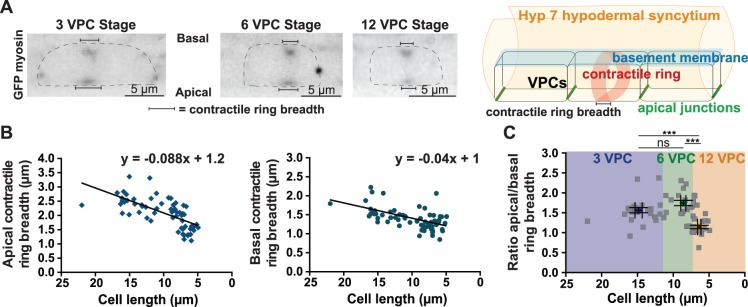
Contractile ring dimensions scale with the length of VPCs.(A) GFP-tagged myosin worms at the 3 (left), 6 (middle) and 12 (right) VPC stages. Images are maximum intensity projections taken at <150 seconds following cytokinesis onset. Myosin is enriched in the contractile ring at both the basal (upper) and apical (lower) domain of the cells. Dotted lines: dividing cells. Scale bar = 5 µm. Right: 3D schematic of a dividing VPC showing contractile ring breadth in brackets. (B) Apical (left) and basal (right) contractile ring breadth plotted against VPC length for all three rounds of division. The x-axis was inverted to show the decrease in cell length through divisions. Best-fit linear regressions and their equations are shown. (C) Scatter plot of apical versus basal contractile ring breadth (data from B) for cell lengths at the 3 (purple), 6 (green) and 12 (orange) VPC stages. Colored dots: average for each stage. Scale bars = mean with SEM for both axes. n.s.: p value = 0.05, ***: p<0.0001, unpaired t-test.